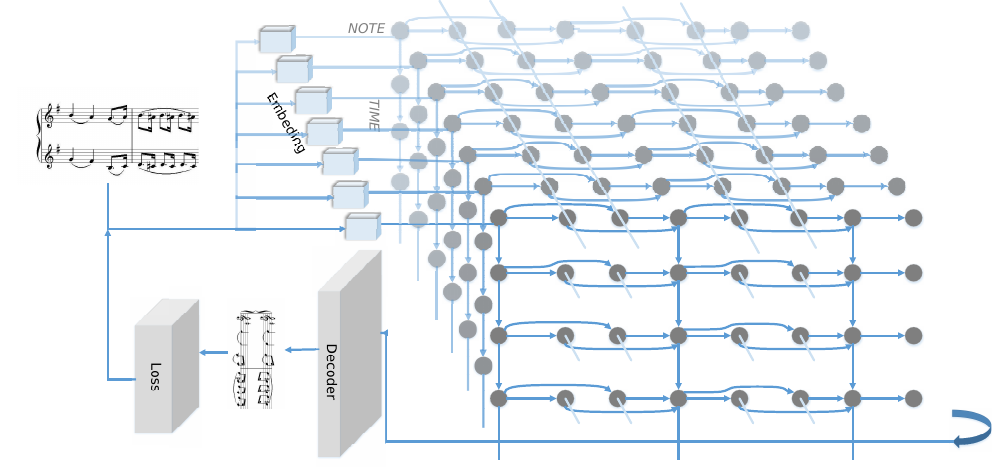
Figure 9. The architecture of BoYaTCN: bidirectional octave your attention temporal convolu- tional